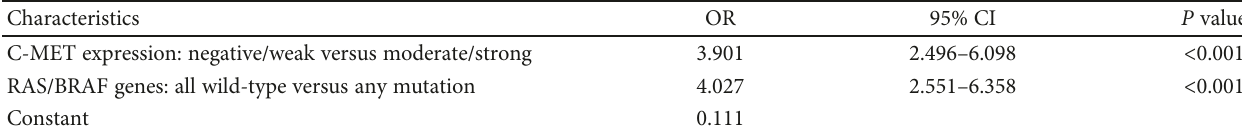
Table 3: Logistic regression analysis of the factors associated with brain and/or lung metastases in metastatic colorectal cancer patients. Characteristics